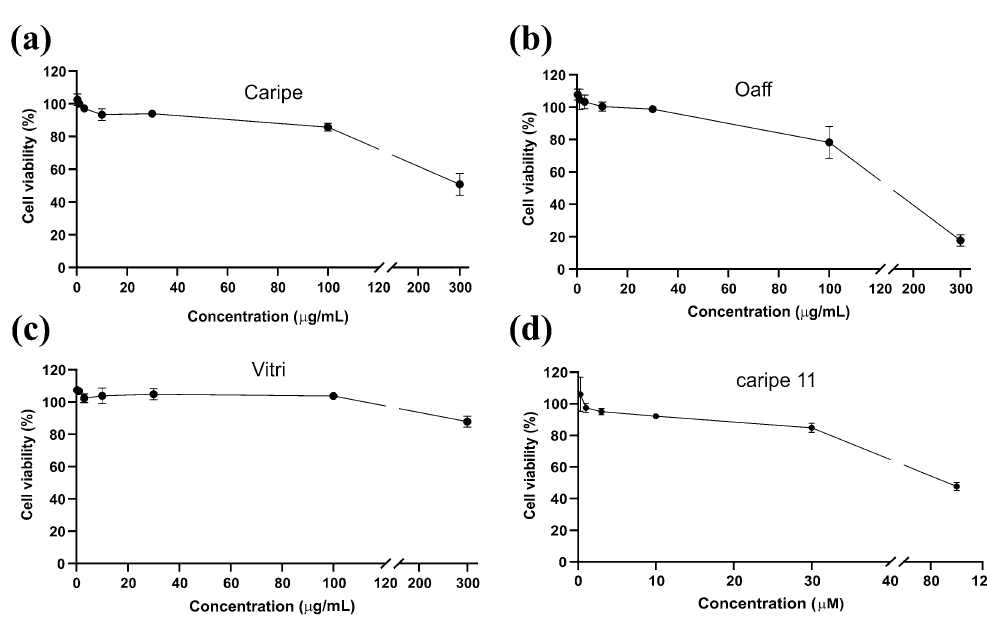
Figure 2. Cytotoxicity of plant extracts and purified cyclotides. Viability of HEK293 cells was determined using the cell counting kit-8 after 2 h incubation with varying concentrations (as indicated in the graphs) of ( a ) extracts of C. ipecacuanha (Caripe), ( b ) O. affinis (Oaff), ( c ) V. tricolor (Vitri), as well as ( d ) purified caripe 11. Cell viability was calculated as percentage using an equation described in the Materials and Methods section using absorbance at 450 nm. Data represent technical triplicates (n = 2) and were expressed as mean ±